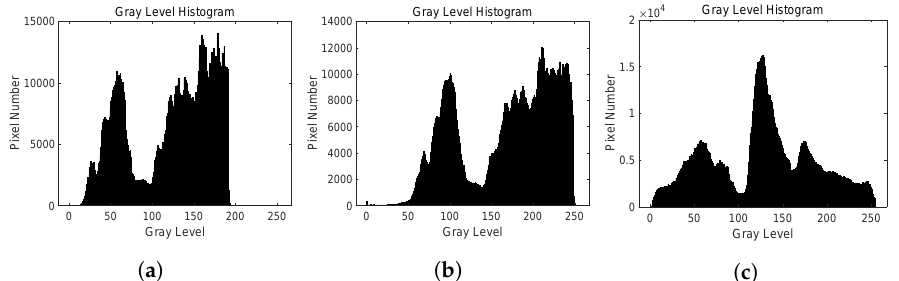
Figure 7. The gray level histogram of the original images and dehazed images. ( a – c ) are the gray level histograms of Figure 5a–c, respectively. Table 1. The quantitative evaluation results of the original images and the dehazed images in Figure